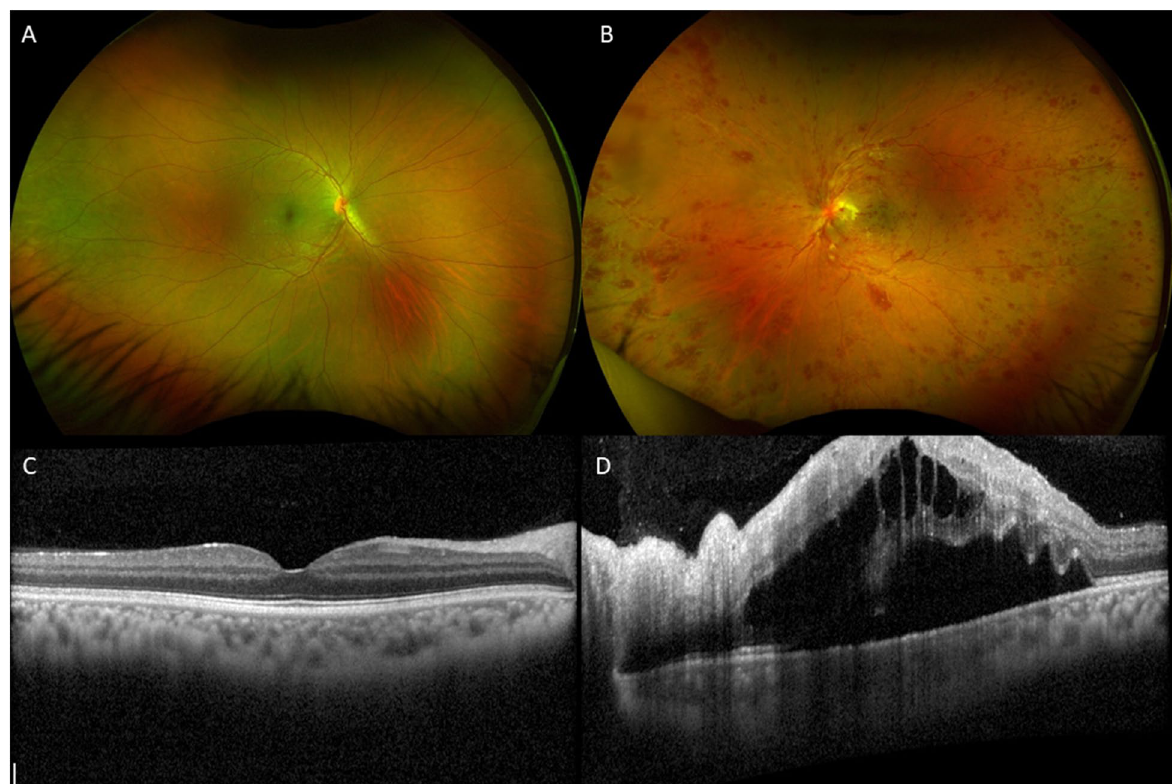
Fig. 1 Wide-field color fundus photos demonstrating normal findings in the right eye ( A ), and optic disc edema, macular edema with peripapillary exudates, venous engorgement with vascular sheathing in nasal periphery, and diffuse hemorrhages consistent with a central retinal vein occlusion in the left eye ( B ). Optical coherence tomography shows no abnormalities in the right eye ( C ), and prominent subretinal and cystic intraretinal fluid with inner retinal thickening nasally in the left eye ( D